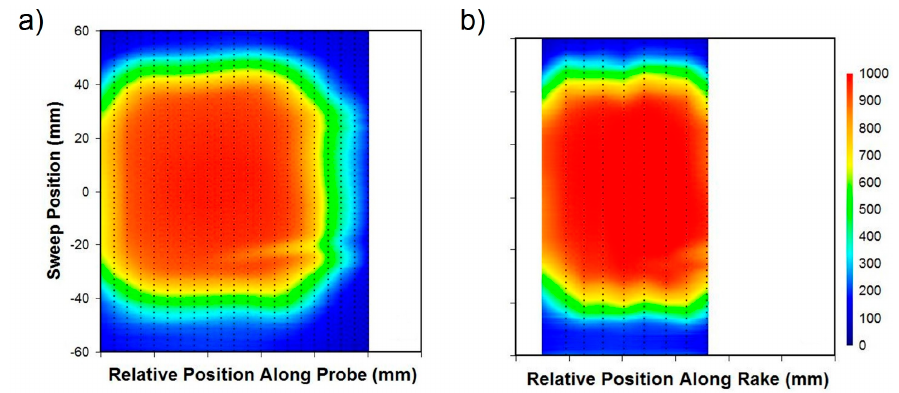
Figure 10. Temperature measurement of the gas turbine combustor simulator exhaust region using ( a ) the FBG sensor array and ( b ) the thermocouple rake. Sensor positions are denoted by the vertical dotted lines.